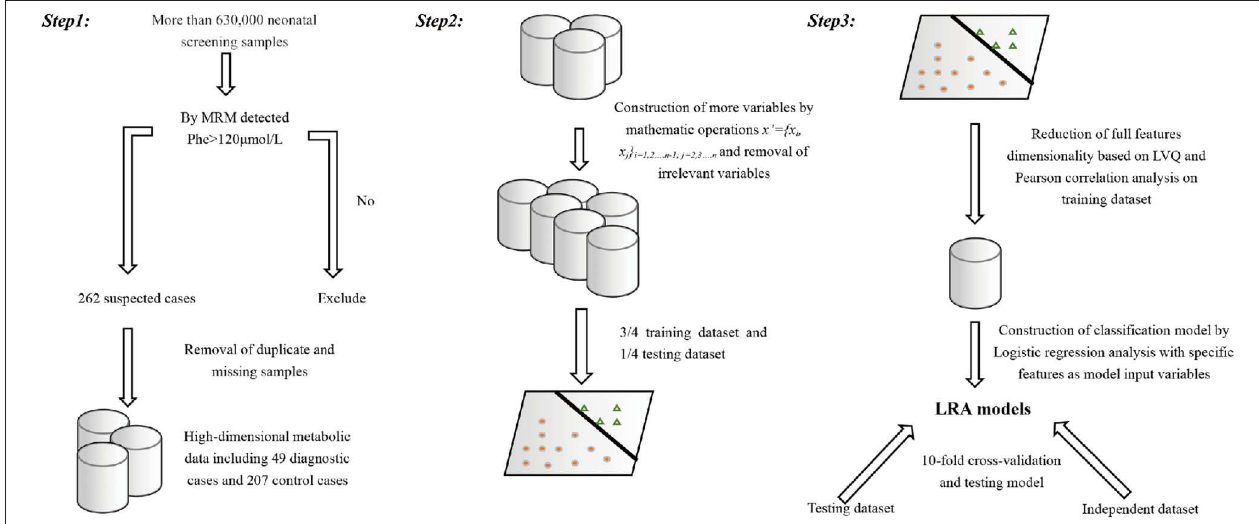
TABLE 3 | The four models developed and the corresponding combination of selected features.